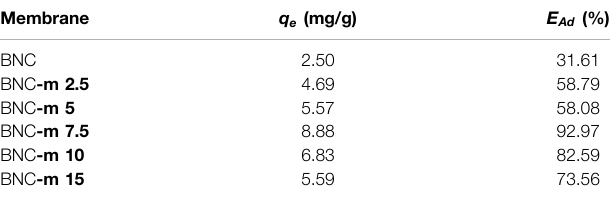
TABLE 4 | Mercury adsorption capacity and ef fi ciency for each membrane. Membrane